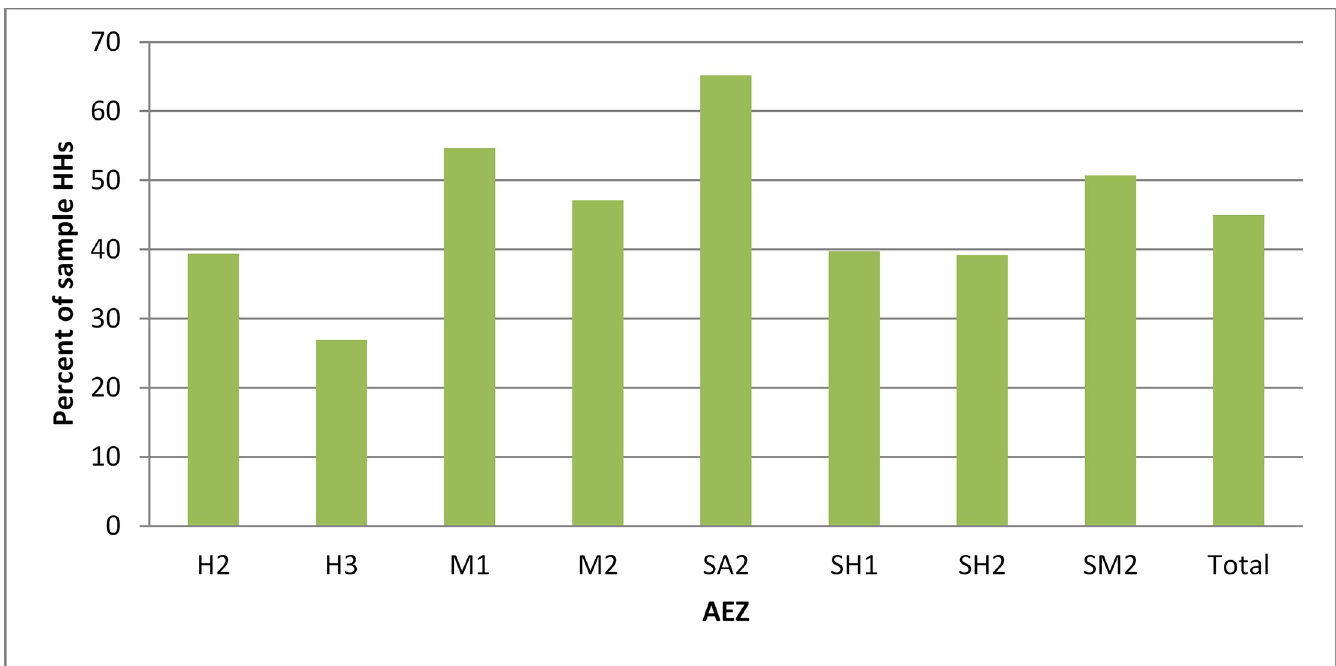
Fig 1. Yellow rust occurrence by agro-ecological zone (AEZ) in 2010/11 production season, Ethiopia (self-reported by sample farmers, 2013/14 survey).